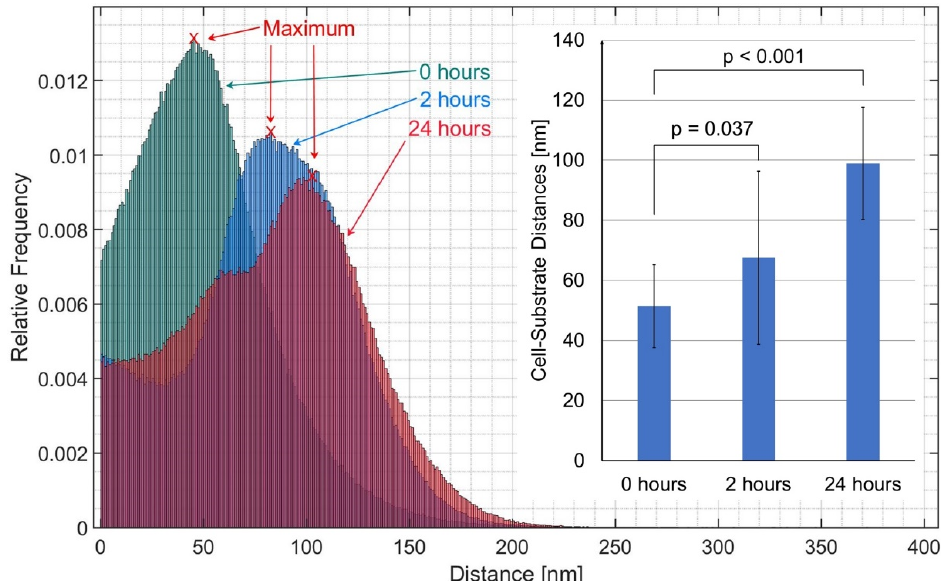
Figure 3. Histograms of cell-substrate distances for representative TIRFM images of CHO-pAcGFP1-Mem cells after 0 h, 2 h, and 24 h incubation with doxorubicin (2 µ M) in cultivation medium. The value at 0 nm (resulting from outside the cells) has been omitted. Inset: most frequent distances evaluated from all histograms as mean value ± standard deviation and p -values for statistical significance obtained from a t -test for 2 samples assuming unequal variances ( p ≤ 0.05: statistically significant). Subcultures with 56–64 cell splittings.